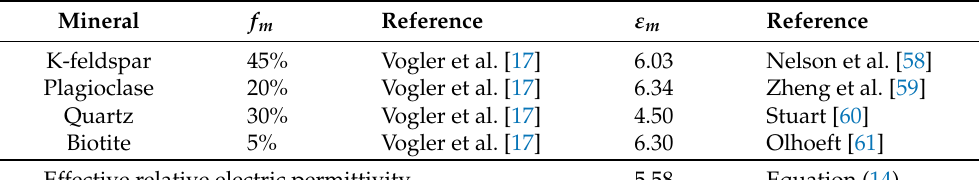
Table 2. Assumed granite mineral volume fractions, f m , and related electric permittivity values, ε m